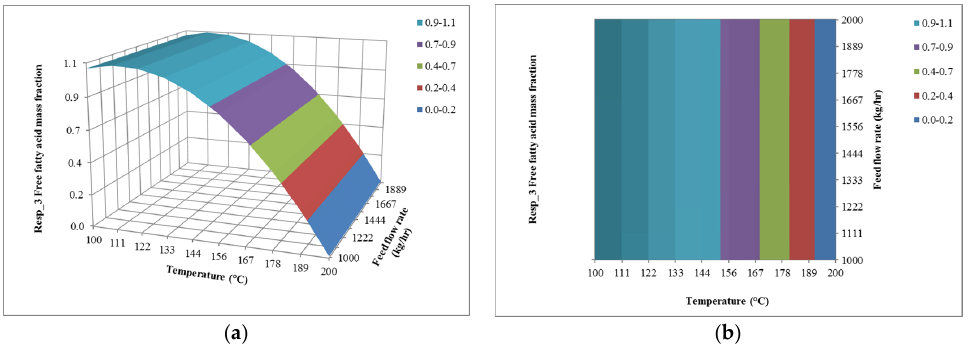
Figure 7. Response surface curve ( a ) and contour plot ( b ) of FFA concentration as a function of temperature and feed flow.